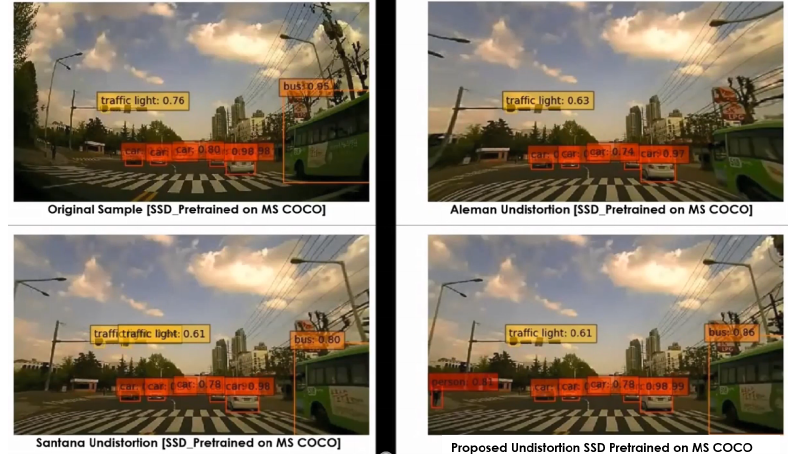
Figure 15. Pretrained SSD object detection on various rectified 120 ◦ wide-angle frames: person detected in the proposed rectified algorithm